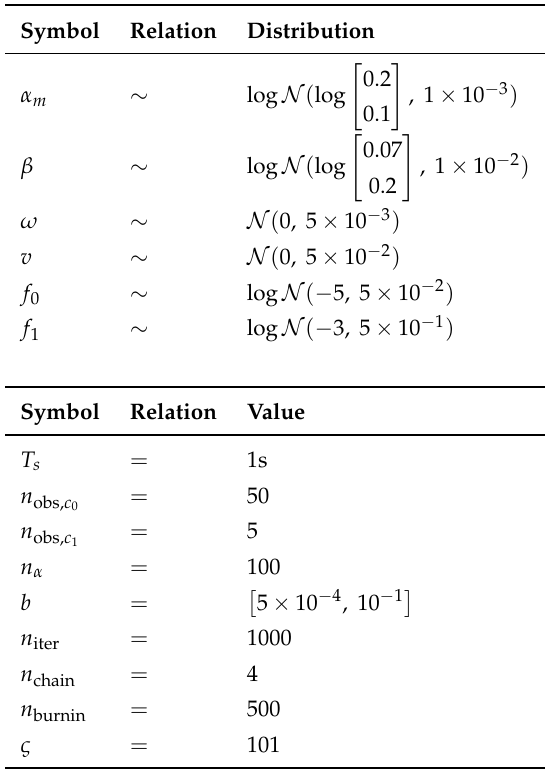
Table A1. Scenario